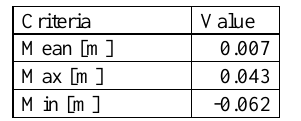
Figure 8. Deviations between TLS-DSM and the adjusted plane of the overflow surface 4 of the polder 2 (view from east)